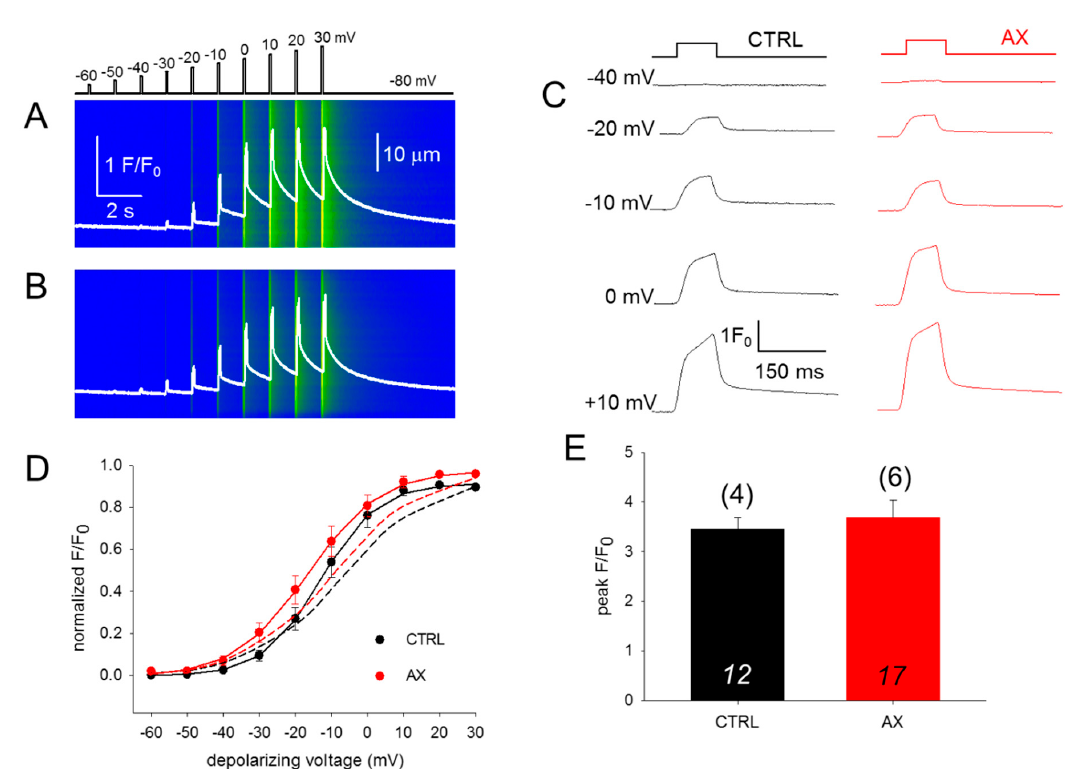
Figure 3. Unchanged release channel sensibility to voltage activation of the FBD muscles observed following 4 weeks AX diet. ( A , B ) Representative line-scan images of rhod-2 fluorescence normalized to the baseline value F 0 (x) in a control ( A ) and AX ( B ) cell subjected to a successive rectangular depolarizing voltage steps under whole-cell voltage-clamp. The cells were held at –80 mV and were perfused with an internal solution containing 10 mM EGTA. The calcium transients were elicited by 100 ms long progressively increasing membrane depolarizations ranging from –60 mV to + 30 mV, with 10 mV increments. The delay between two pulses was 1100 ms. The white trace is the temporal profile of the normalized fluorescence obtained by averaging 50 lines in the spatial domain normalized to average resting F 0 (x) values. ( C ) The temporal profiles of the normalized fluorescence at individual 100 ms long depolarizing pulses as indicated for single FDB fibers from CTRL and AX mice. ( D ) Voltage dependence of the calcium transients. The normalized F / F 0 values were fitted with a Boltzmann function (see Equation (2) in Methods) and then normalized to the obtained maximum for a given fiber and lastly averaged over the fibers in each group. The continuous lines represent the best fit of the Boltzmann function to the average values with the following parameters: V 50 = –13.03 and –16.57 mV, k = 7.91 and 10.04 for CTRL ( n = 12 fibers, N = 4 mice) and AX ( n = 17 fibers, N = 6 mice), respectively. The dashed lines indicate the best fit of the Boltzmann function of the individual depolarizing pulses (applied every 2 min) with the following parameters: V 50 = –6.73 and –9.18 mV, and k = 12.47 and 12.57 for CTRL and AX, respectively. ( E ) Pooled data for peak F / F 0 values obtained at close to maximal depolarizing pulses ( + 10 mV). The numbers in italics indicate the number of cells studied, whereas the numbers in parenthesis denote the number of animals